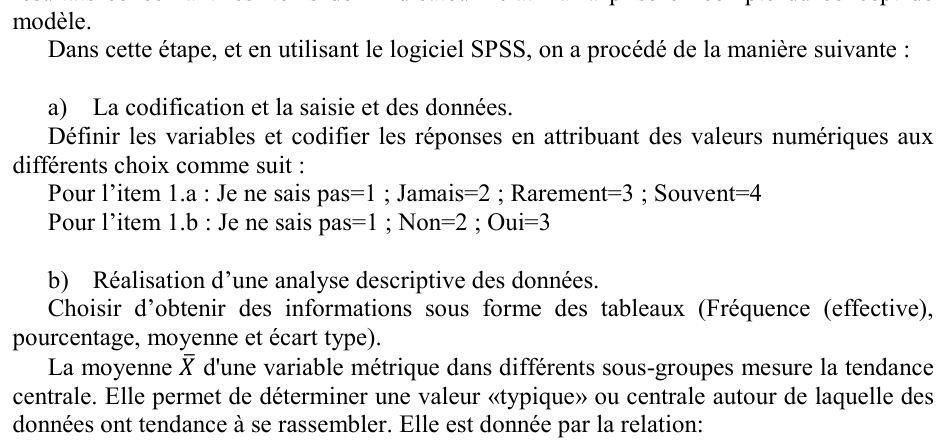
Table 1. Répartition des étudiants